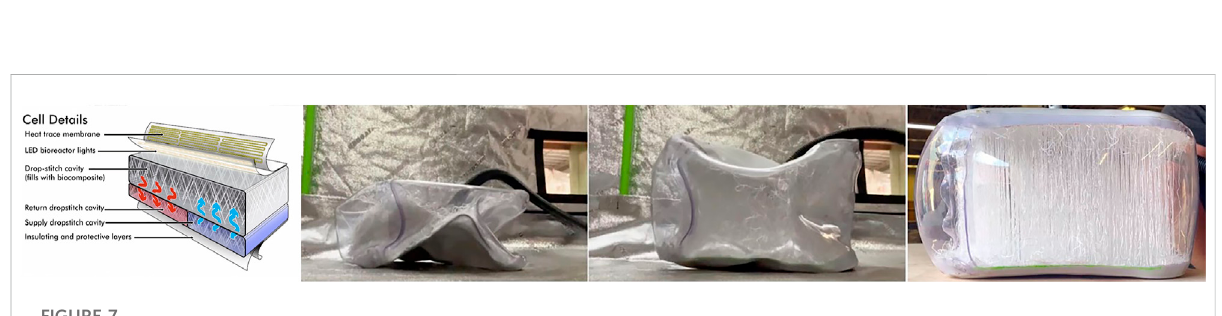
FIGURE 7 Drop-stitch technology, in fl atable prototype, redhouse